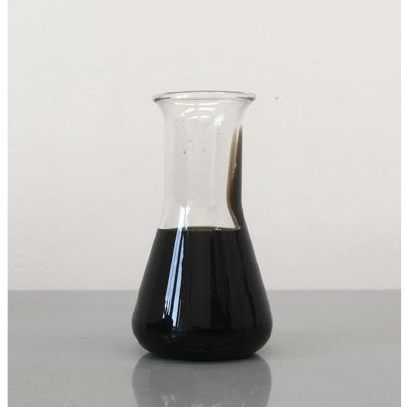
Figure 2. The decantated, filtered and mixed in equal proportions waste engine oil